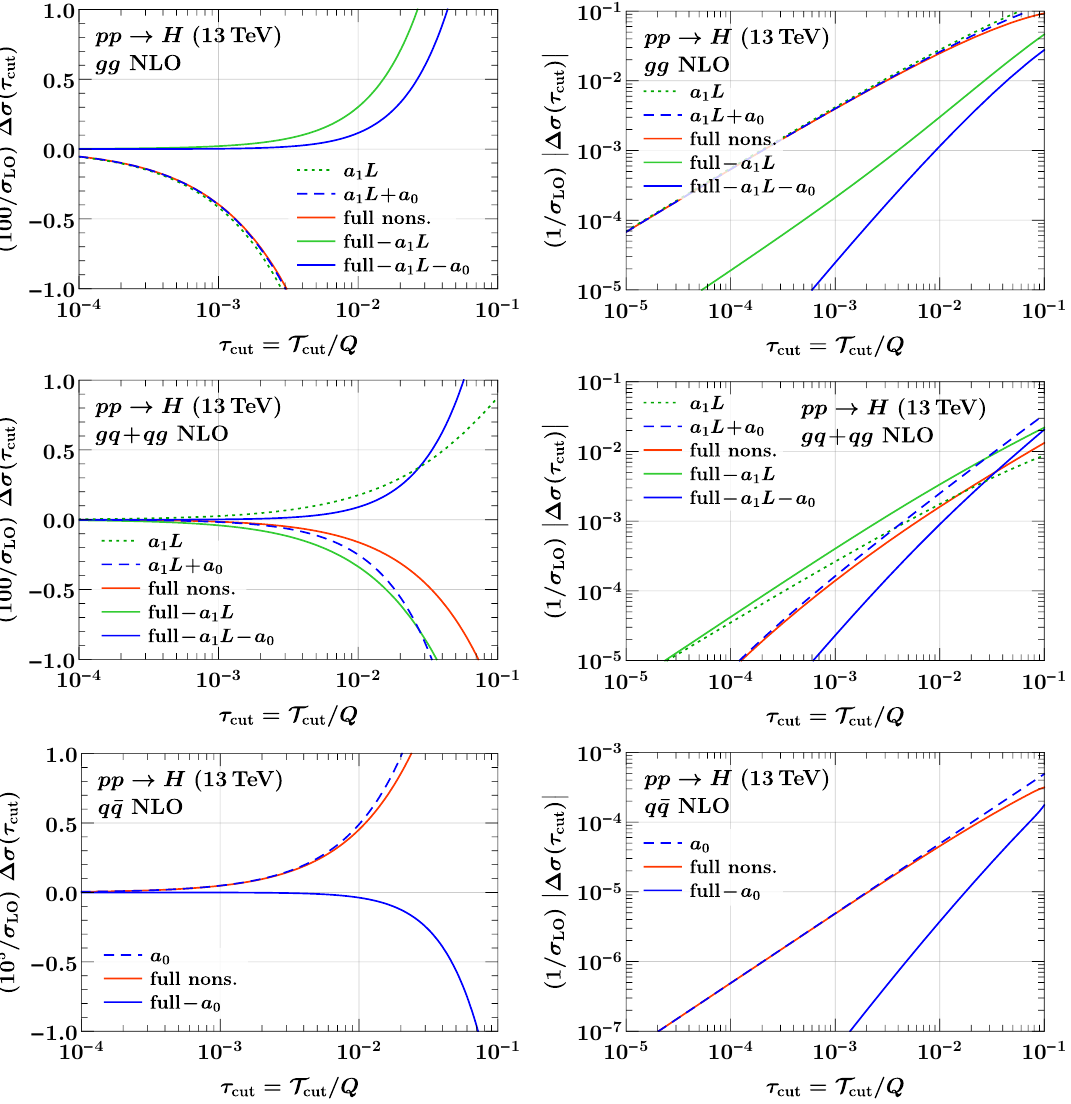
Figure 8 . The power corrections for the cumulant (cid:1) (cid:27) ( (cid:28) cut ) at O ( (cid:11) s ) for Higgs production in the gg channel (top row), gq + qg channel (middle row), q (cid:22) q channel (bottom row).